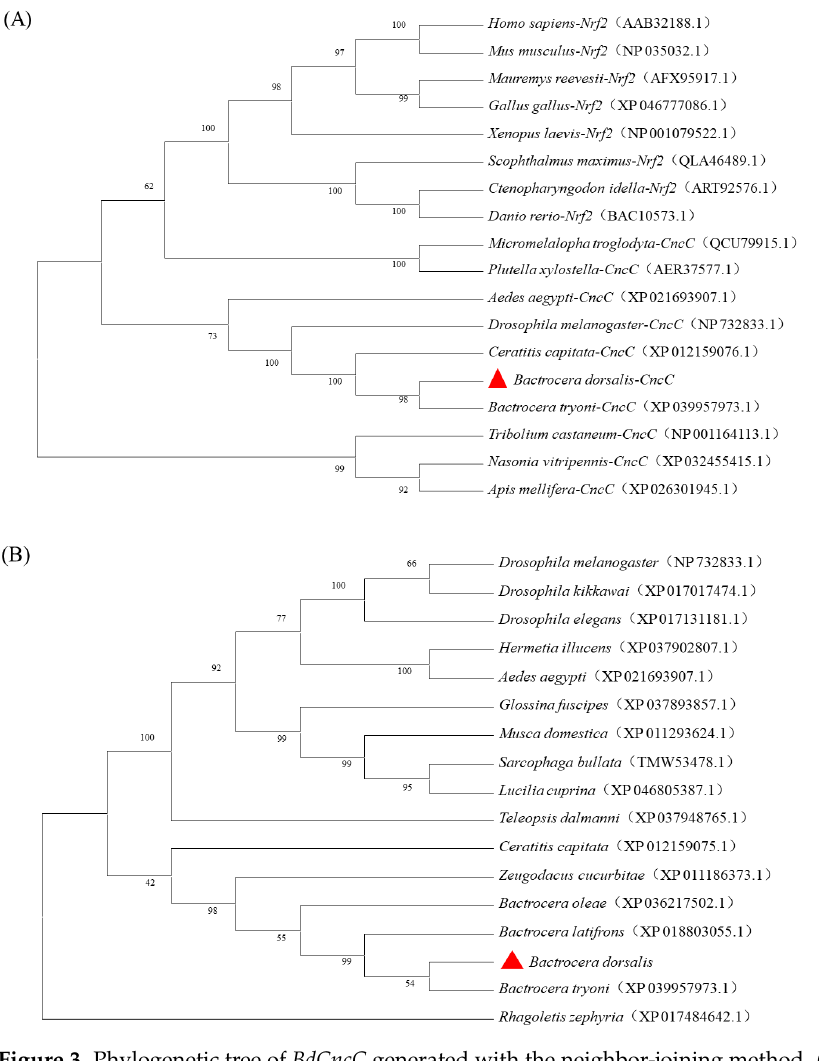
Figure 3. Phylogenetic tree of BdCncC generated with the neighbor-joining method. ( A ) Phyloge- netic tree of CncC and Nrf2 ; ( B ) phylogenetic tree of dipteran CncC sequences. The numbers along the branches indicate bootstrap support from 1000 replicates; ( ) represent CncC in B. dorsalis .